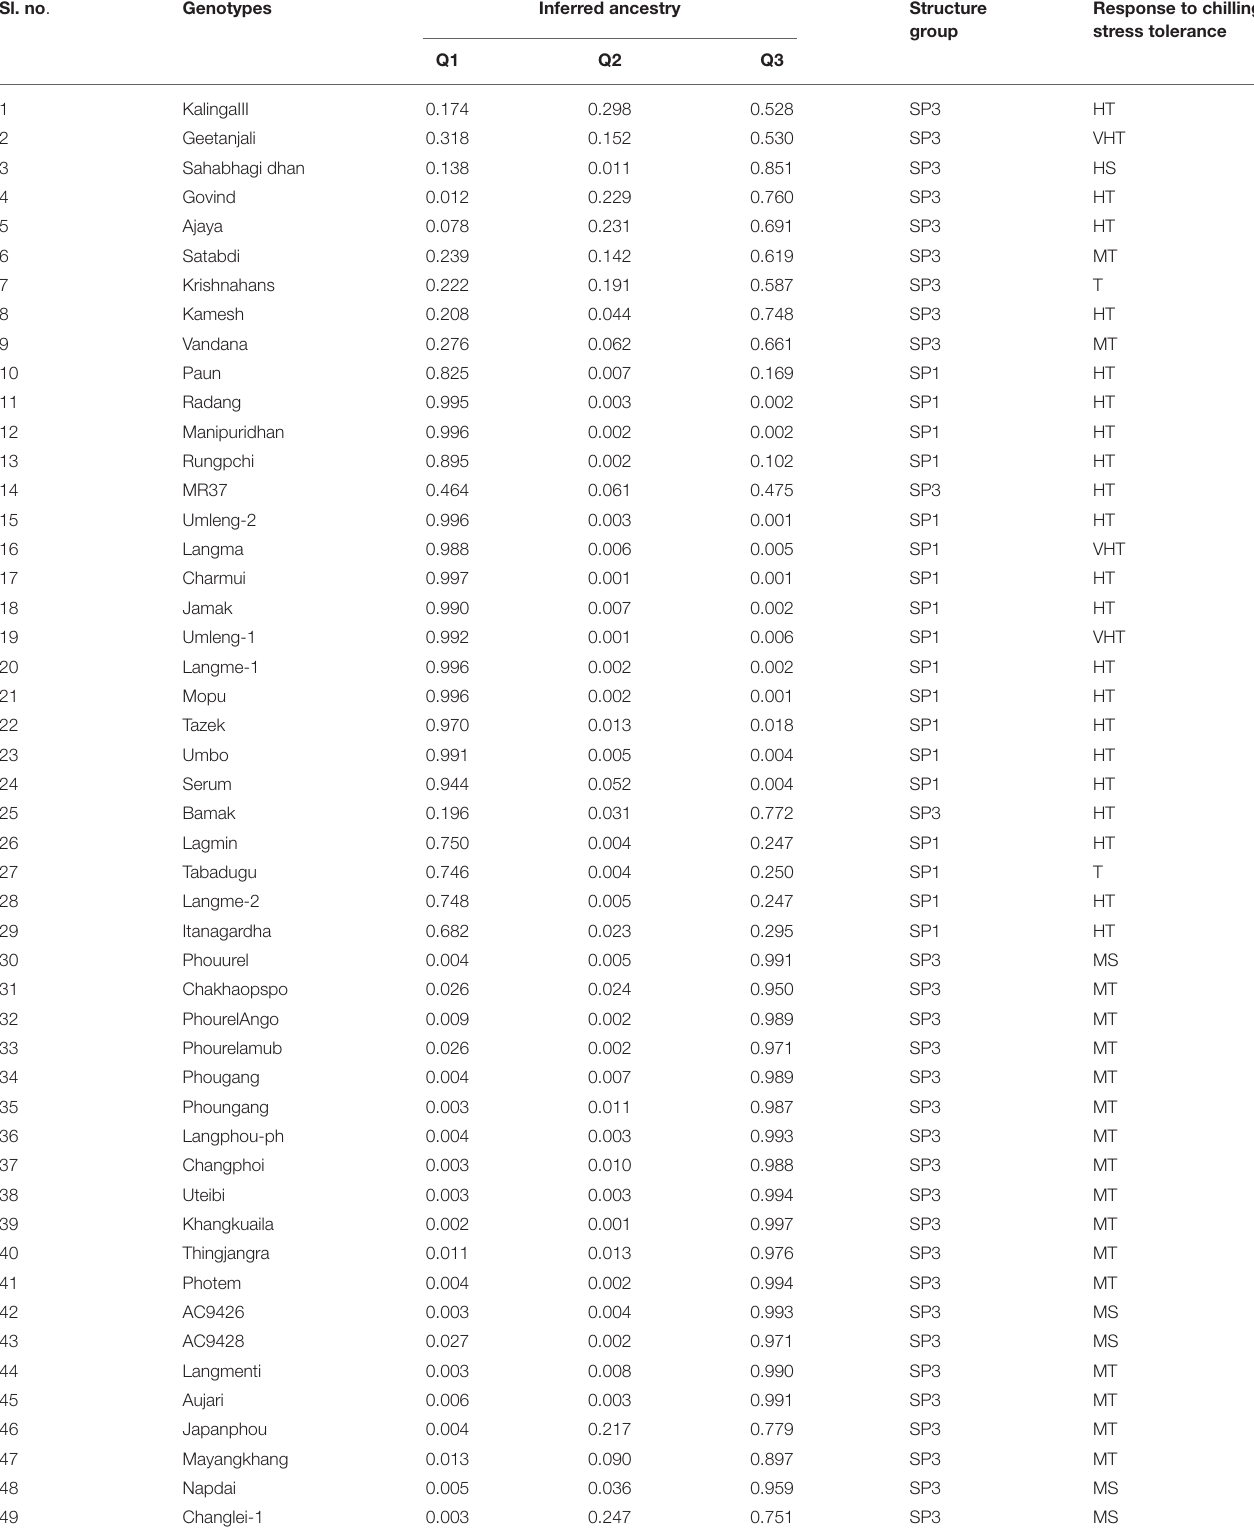
TABLE 4 | Population structure group of accessions based on inferred ancestry values. Sl. no . Genotypes Inferred ancestry Structure